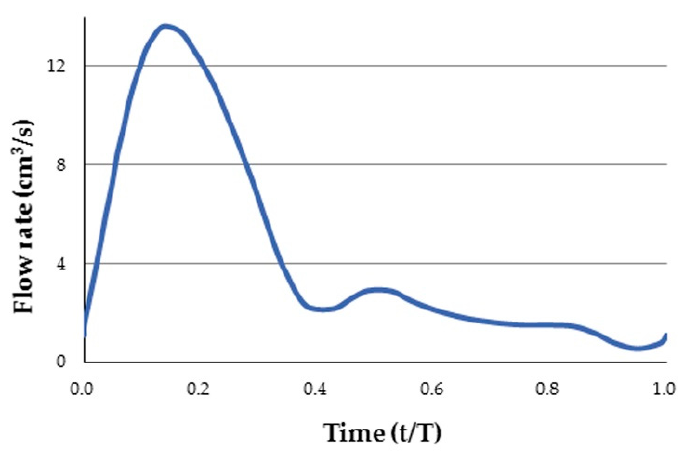
Figure 2. Fully-developed pulsatile flow prescribed at the inlet.